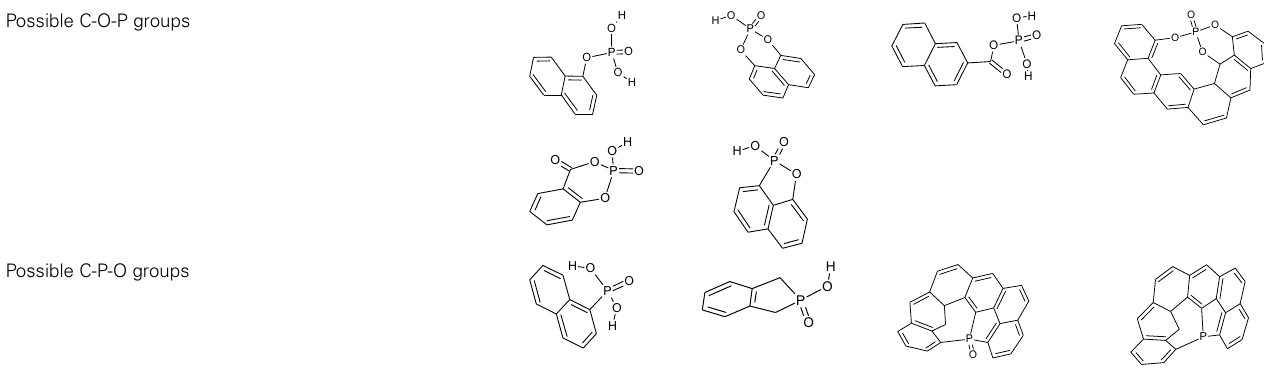
Table 2 | Possible phosphorus surface groups formed during H 3 PO 4 activation, as C-O-P and C-P-O groups . Possible C-O-P